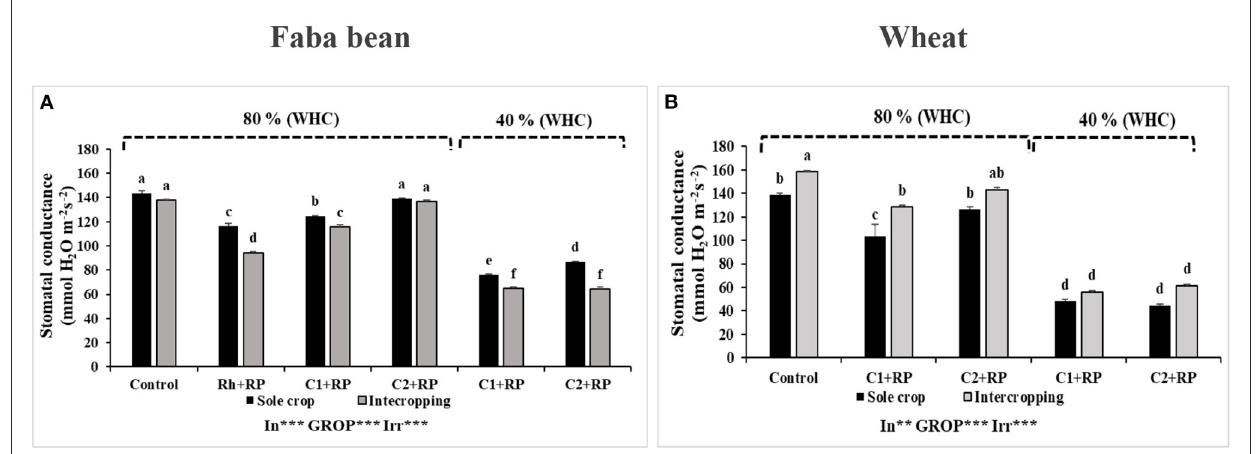
FIGURE1 Stomatal conductance of faba bean (A) and wheat (B) grown as a sole crop or intercropped under water sufficiency and P limitation (80% WHC, RP) vs. combined water deficit and P limitation (40% WHC, RP) and inoculated with two rhizobacterial consortia (C1 and C2) containing rhizobia and two PGPRs. The positive controls were supplemented with 125 µ mol/l of KH 2 PO 4 and 46 mg/l of KNO 3 (control). The negative controls received RP and were inoculated with the rhizobia only (Rh + RP). Each value represents the mean ± standard error (SE) of three replicates (In, inoculation; GROP, type of cropping; Irr, irrigation). Values with different letters are significantly different at 0.05 level of probability by Student-Newman-Keuls. * Represent the significance level of treatments.